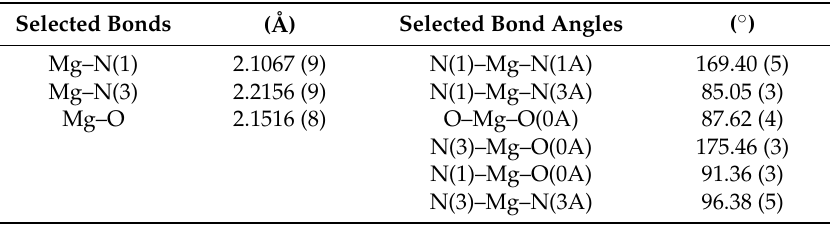
Figure 1. Molecular structure of 1 . Hydrogen atoms are omitted for clarity. Table 2. Selected bond lengths (Å) and bond angles (°) for 1 .